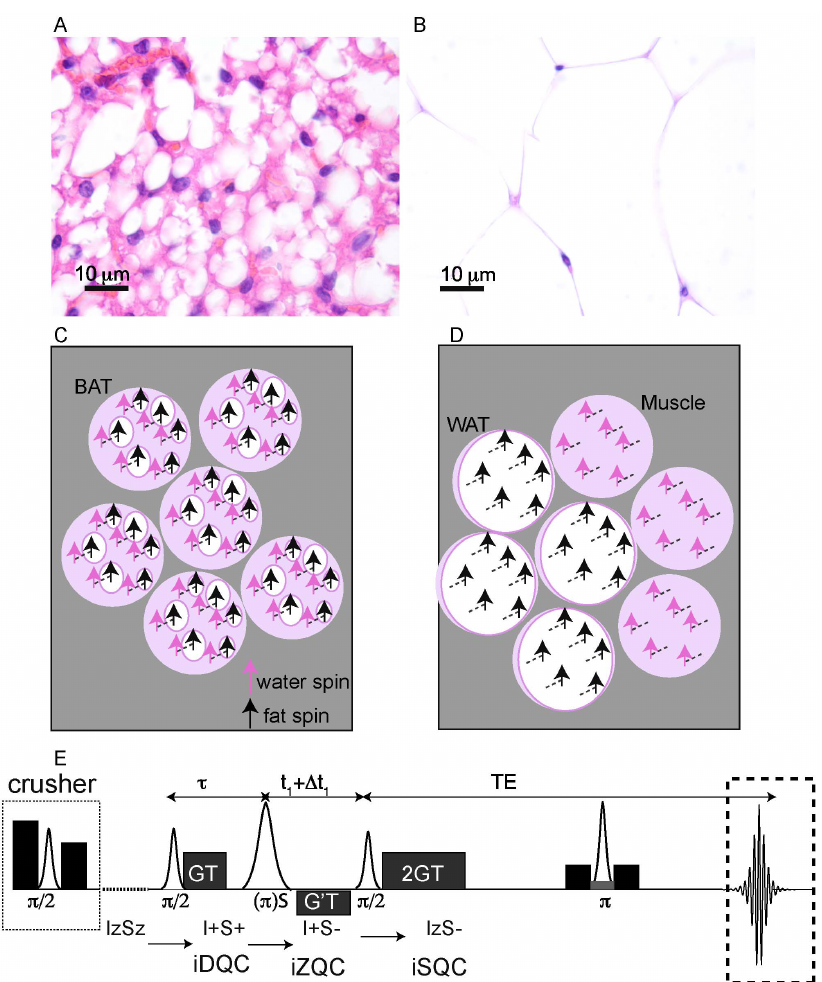
Figure 1. Origin of the water-fat iZQC signal from BAT (BATSCI). ( A–B ) Histological haematoxylin and eosin (H&E) staining of BAT ( A ) and white fat ( B ) from a mouse showing different cell morphologies. Brown fat cells present multiple smaller lipid vacuoles and higher hydration level and are usually smaller than white fat cells, which are made by a single large lipid droplet. ( C ) Cartoon showing the different cellular structures and the origin of the iZQC signal in BAT: unlike in white fat, in BAT water and fat spins are mixed together at the cellular level such that the selection of a small correlation distance can select the BATSCI signal only from BAT ( D ) Scheme of the radio frequency pulse sequence used in the experiments for the detection of